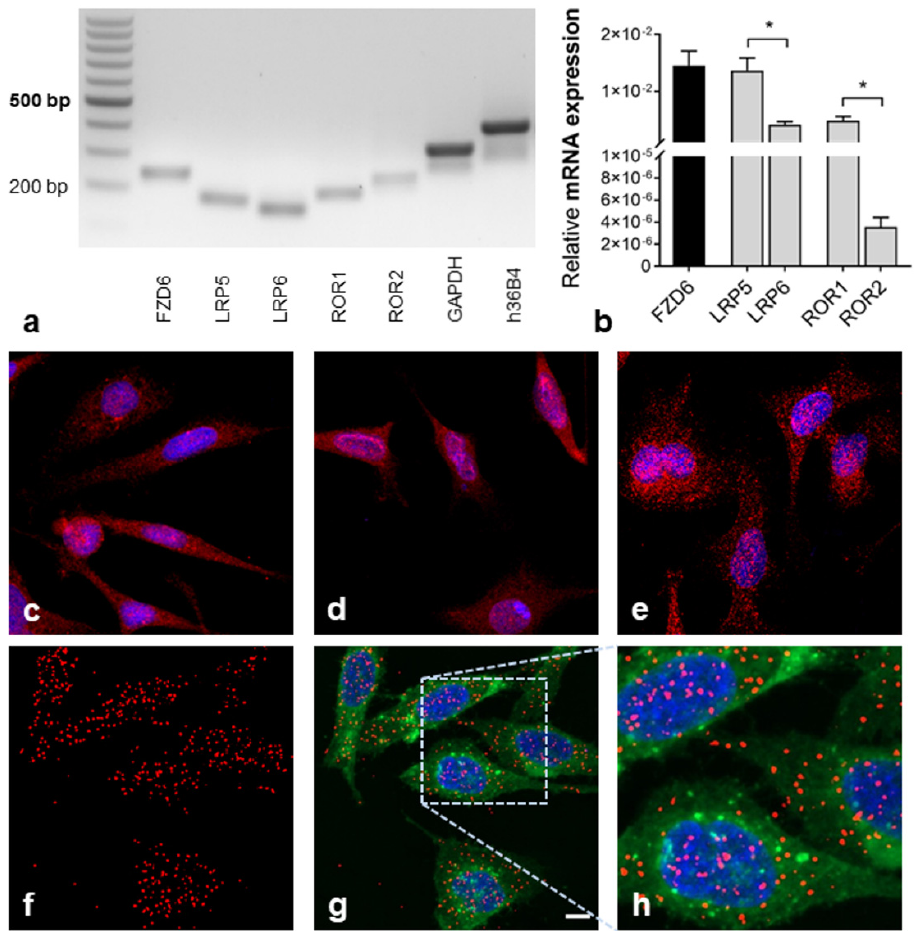
Figure 1. Wnt (co-)receptor expression and interactions. ( a , b ) Wnt (co-)receptor expression by qRT-PCR. ( a ) Qualitative presentation of the expression; ( b ) Relative mRNA expression of target genes was quantified (normalized to h36B4 expression). Quantification revealed high expression of FZD6, LRP5/6, and ROR1, while ROR2 was almost not expressed (* p ≤ 0.05, Mann–Whitney Test); mean + SD; n = 3 independent experiments. ( c – e ) Immunofluorescence staining of FZD6 ( c ), LRP6 ( d ), and ROR1 ( e ). Receptors (red); nuclei (blue). ( f – h ) Visualization of the co-localization between FZD6 and co-receptors by PLA. Prominent fluorescent spots indicate receptor interactions, exemplarily shown for FZD6–LRP6, ( f ) Cy3-PLA for FZD6–LRP6; ( g , h ) merged images of Cy3-PLA, membrane labeling by Alexa Fluor 488 ® -coupled wheat-germ agglutinin (WGA) and nuclei staining with DAPI, ( d , e ) merged images. FZD6–LRP6 complexes (red); plasma membranes (green); nuclei (blue). Scale bar: 10 µm.